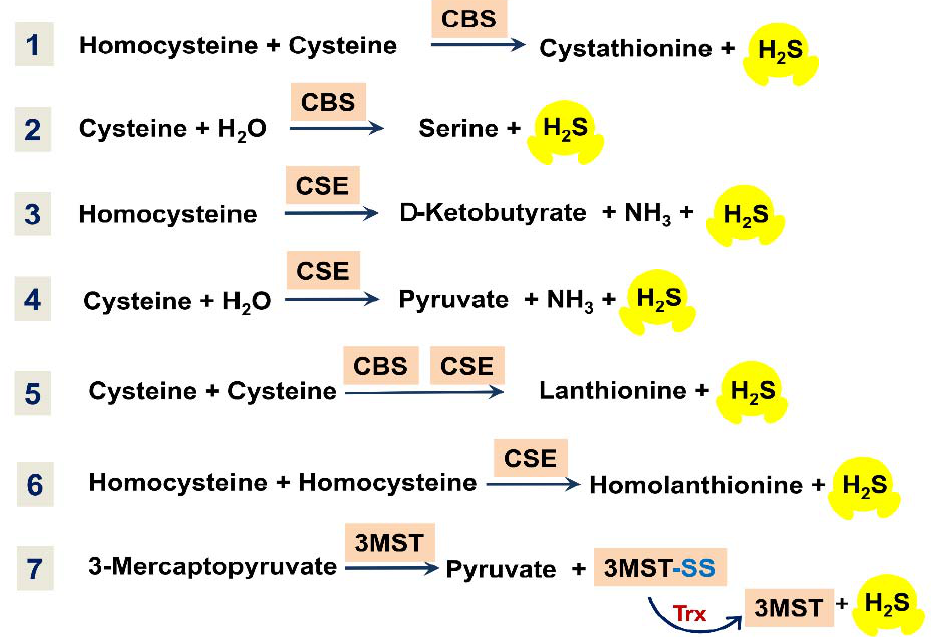
Figure 3. Overview of main reactions for enzymatic production of H 2 S in mammalian tissues. The majority of bacterial species whose genomes were completely sequenced have the orthologs of mammalian genes encoding CBS, CSE, or 3MST [15]. Since H 2 S provides defense against modern antibiotics in bacteria, suppression of H 2 S-producing enzymes in pathogens by new drugs would be a promising antimicrobial treatment strategy [15,27]. The use of H 2 S biogenesis as a target for versatile antibiotic potentiators may have therapeutic potential for the fight against difficult-to-treat infections based on bacterial antibiotic